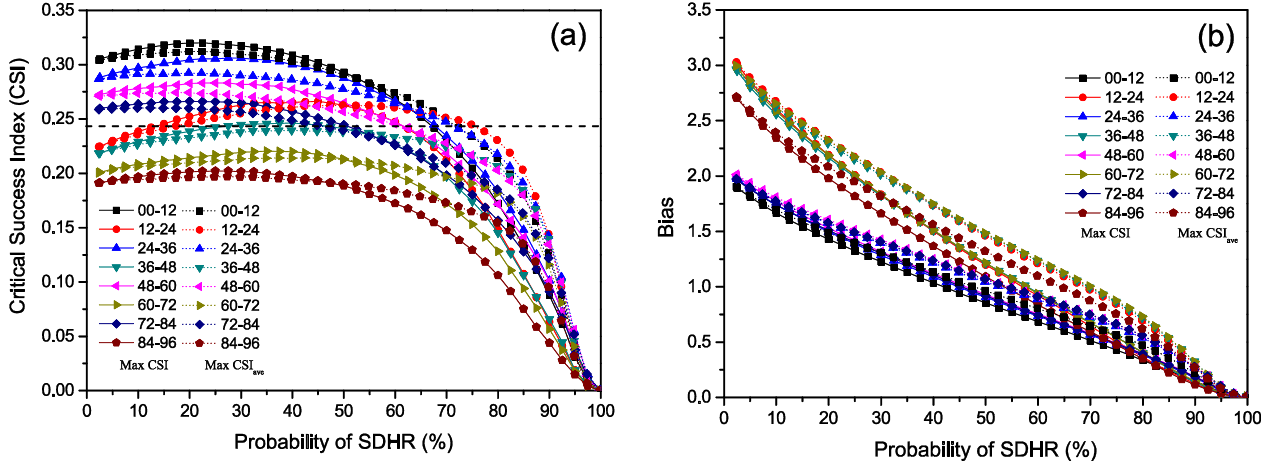
Figure 6. Variation of ( a ) CSI and ( b ) bias for 00–12, 12–24 . . . 72–84, and 84–96 h probabilities of SDHR for the groups with the highest maximum CSI and the highest CSI ave during the 00–12 h forecasts. The dashed horizontal line in Figure 6a represents the reference CSI.